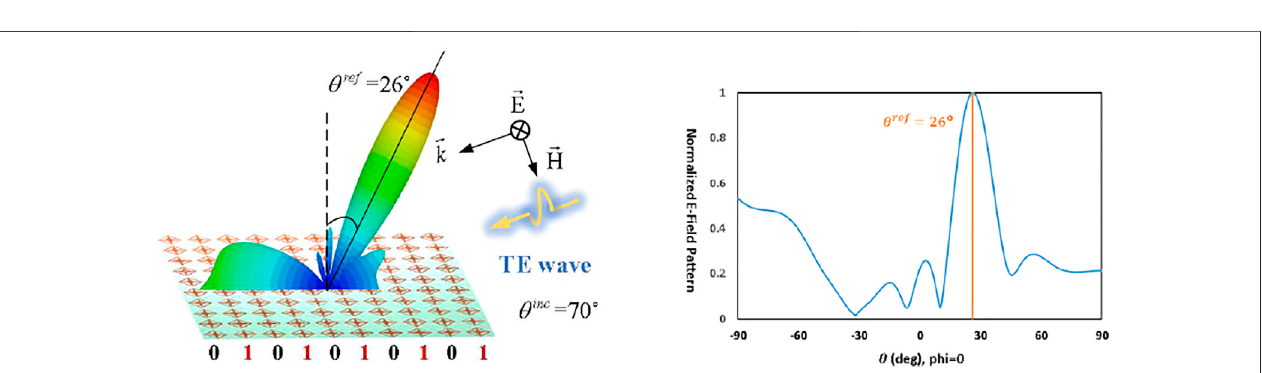
FIGURE 8 | Electrical fi eld pattern of the proposed programmable metasurface with “ 0101 ... ” coding sequence at 70 o oblique